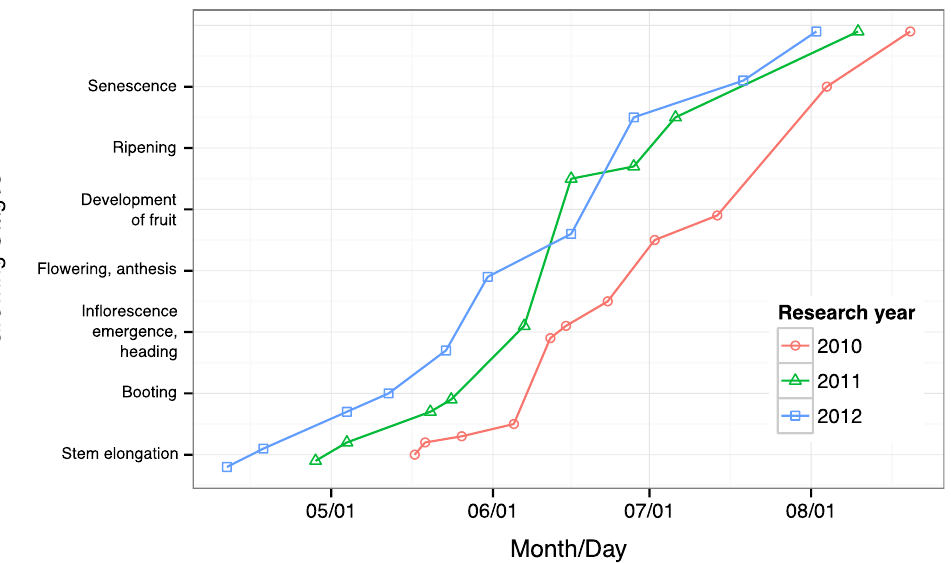
Figure 3. Wheat growing stages (Zadoks-scale) for the three years of field experiments. Only the main growing stages appear in the graphic. Each symbol on the graph represents the date of measurement. The last measurements were taken right before the harvest. * Germination, leaf development, and tillering stages are not